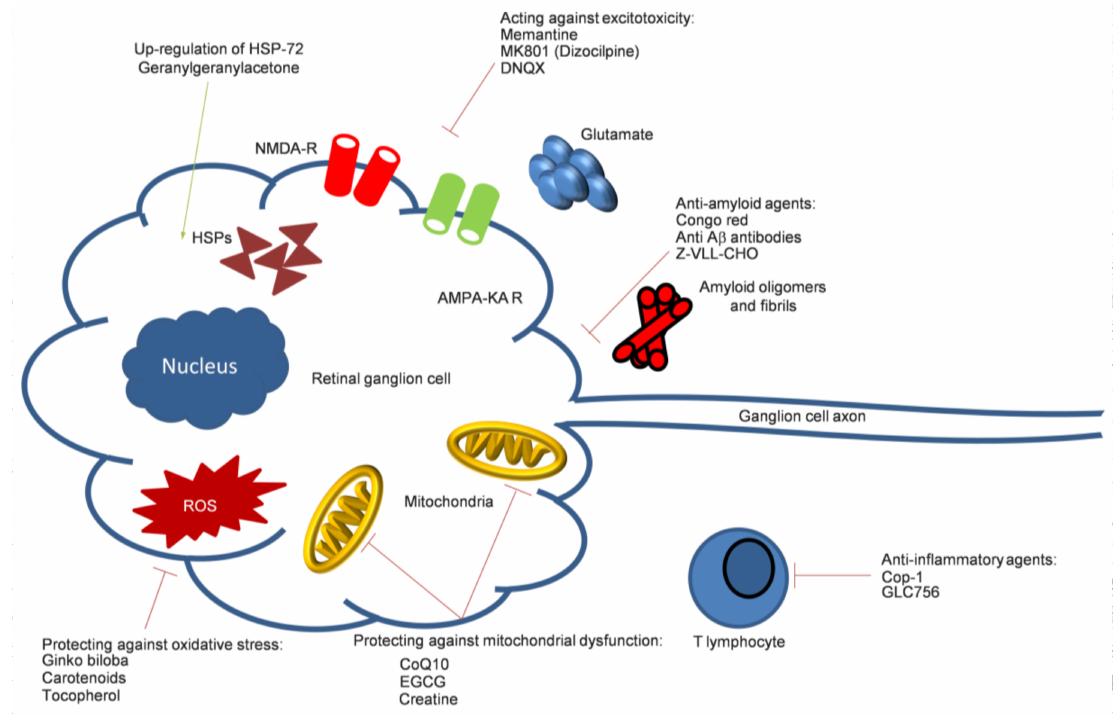
Figure 1. A diagrammatic summary of possible neurodegenerative mechanisms and their targeting (represented by line indicators, green: excitatory, red: inhibitory) in glaucomatous damage (Cop-1: Copolymer-1; CoQ10: Coenzyme Q10; DNQX: 6,7-Dinitroquinoxaline-2,3-dione; EGCG: Epigallocatechin galleate; Z-VLL-CHO: